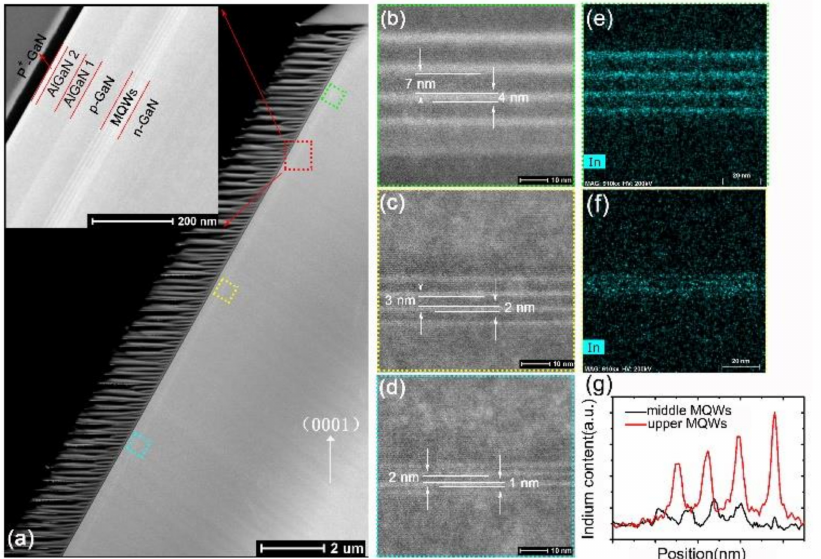
Figure 2. ( a ) HAADF TEM image of the semi-polar plane of a single µ -LED pyramid. The inserted image shows the low-magnification epitaxial layer containing the MQW. HAADF images of the MQW regions taken from regions A ( b ), B ( c ), and C ( d ) of the semi-polar planes, and corresponding EDS mappings showing the In content in regions A ( e ) and B ( f ) of the semi-polar MQWs. ( g ) Line scan of the In content across the MQW in the upper and middle parts of the semi-polar